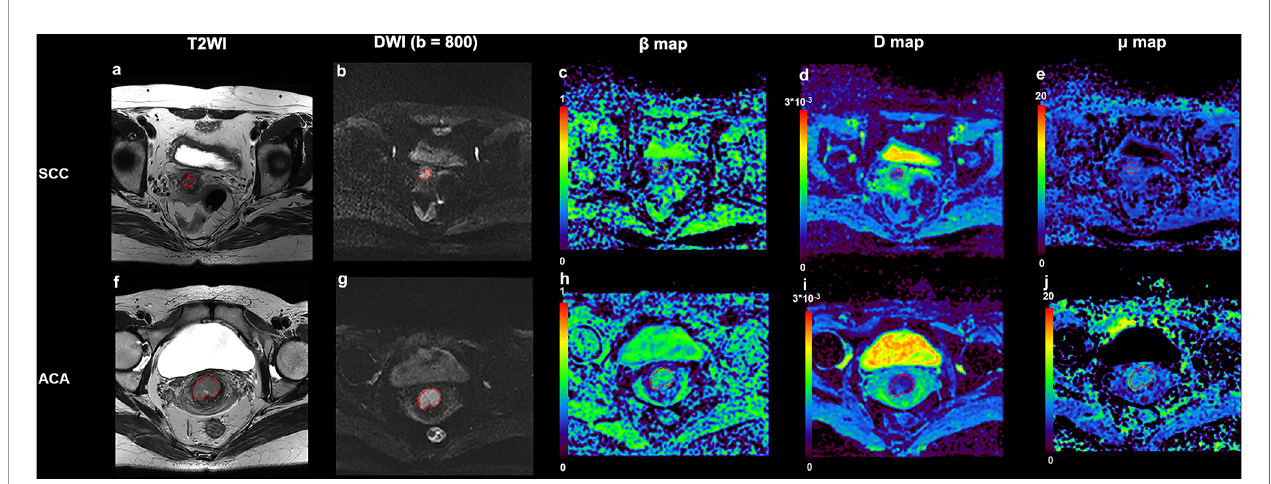
FIGURE 1 | An example of SCC from a 70-year-old patient and ACA from a 56-year-old patient. (A) Transverse T2 image for patient with SCC; (B) DWI image (b = 800 s/mm 2 ) for patient with SCC; (C) b map for patient with SCC; (D) D map for patient with SCC; (E) m map for patient with SCC; (F) Transverse T2 image for patient with ACA; (G) DWI image (b = 800 s/mm 2 ) for patient with ACA; (H) b map for patient with ACA; (I) D map for patient with SCC; (J) m map for patient with SCC. SCC, cervical squamous cell carcinoma; ACA, cervical adenocarcinoma; DWI, diffusion-weighted